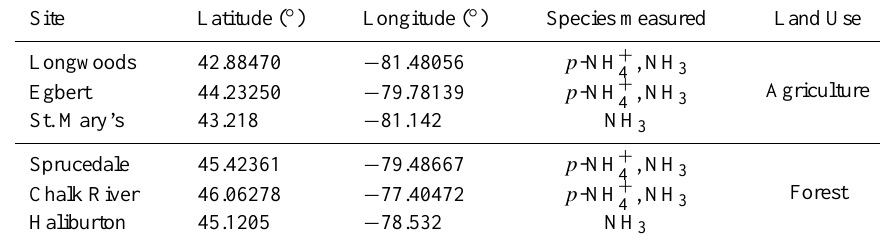
Table 1. Information regarding the six measurement sites in this